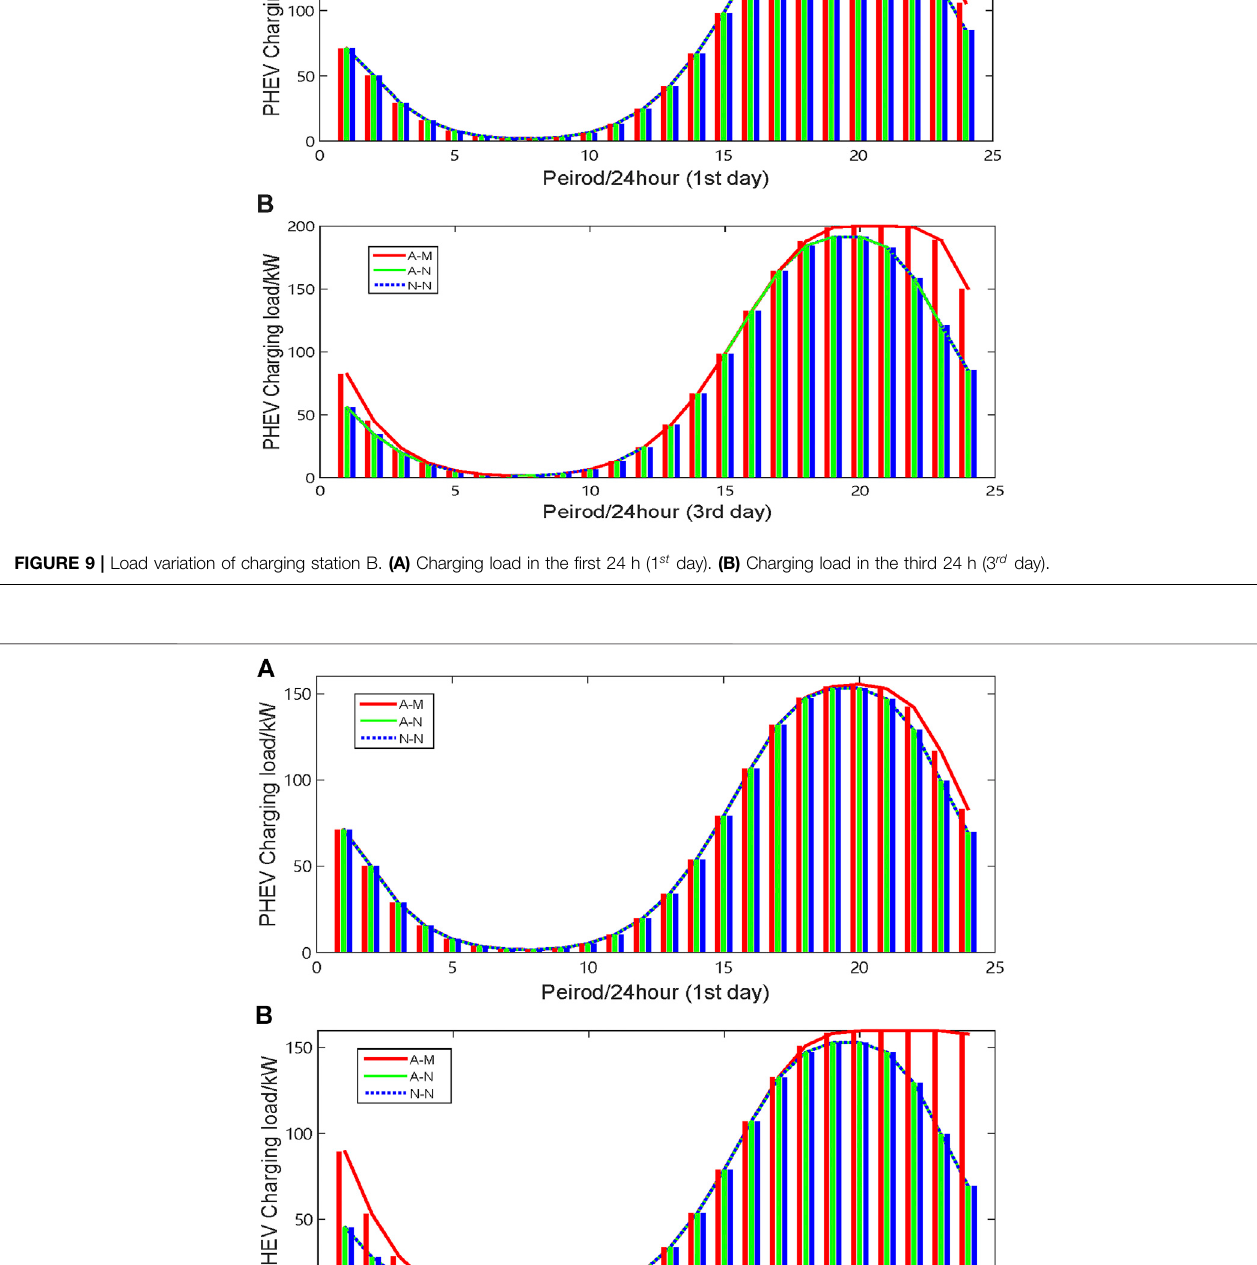
Frontiers in Energy Research |